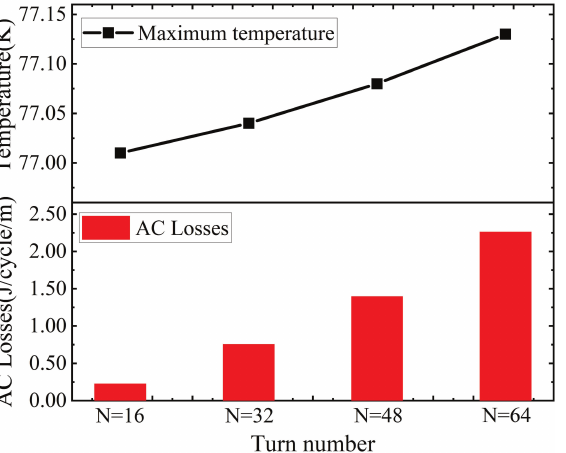
Figure 6. Loss and temperature under different coil turns (I max = 60